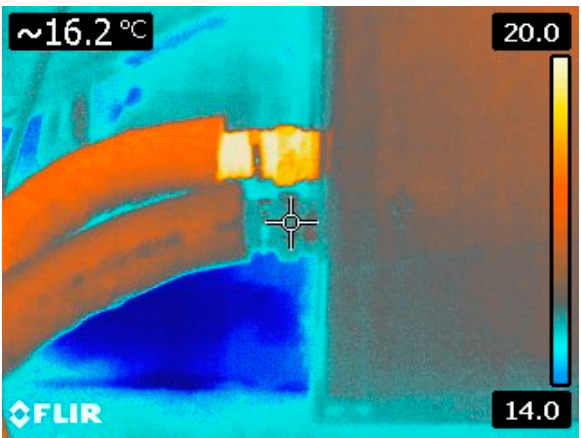
Figure 2. Thermogram of the borehole heat exchanger (BHE) connection to the thermal response tests (TRT) apparatus.